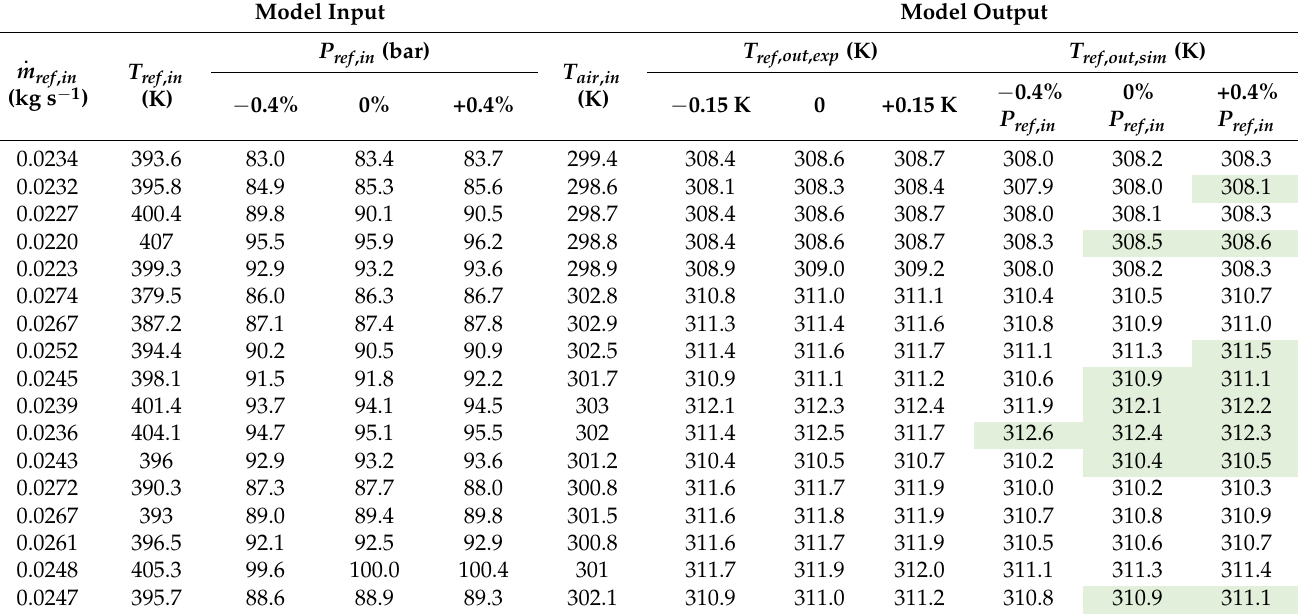
Table 3. Effect of the inlet pressure variation of the refrigerant due to the accuracy of the piezoelectric sensors on the predicted outlet temperature of the refrigerant. The actual measured value is considered for the other inputs. The simulated values within the range of error of the temperature sensor are highlighted with a green